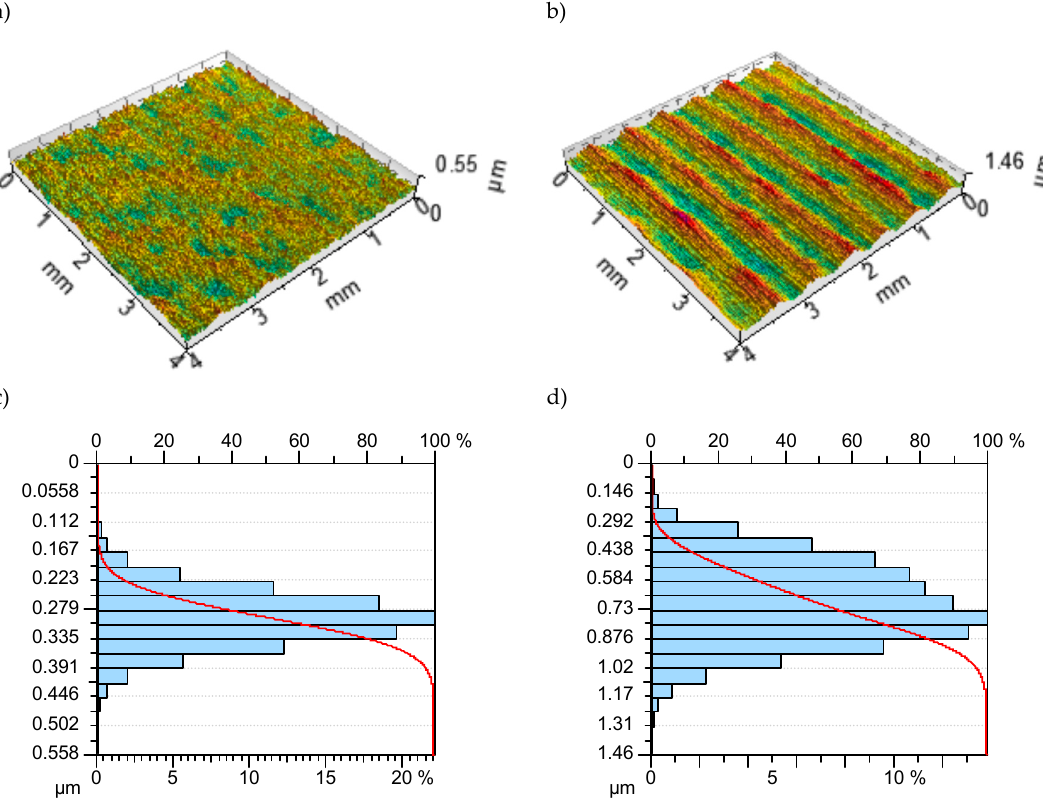
Figure 3. Isometric views ( a , b ) and Abbott–Firestone curves with distribution of surface ordinates ( c , d ) for the samples with the lowest ( a , c ) and the highest ( b , d ) value of the Sq parameter. The texture aspect ratio of ball-burnished disc samples Str was lower than 0.245. The Str parameter is a measure of surface texture and ranges between 0 and 1 (values close to 1 indicate a high level of isotropy). Values lower than 0.245 indicate the anisotropic character of the burnished surfaces. The value of the length of the fastest decay of the autocorrelation function in any direction Sal in most of all practical applications is set to 0.2. Large values of the Sal parameter denote surfaces dominated by low-frequency components, while small values of that parameter indicate the opposite. Most burnished samples were characterized by a lower value of Sal than ground surface and, thus, were dominated by higher-frequency components. The only exception was the sample in variant 1, where the Sal parameter reached the value of